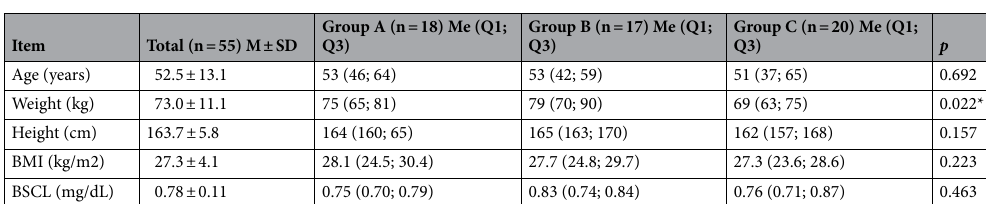
Table 1. Baseline demographic data. BMI body mass index, BSCL baseline serum creatinine level, M mean, SD standard deviation, Me median, Q1 quartile 1st, Q3 quartile 3rd, n number of participants, p level of statistical significance.